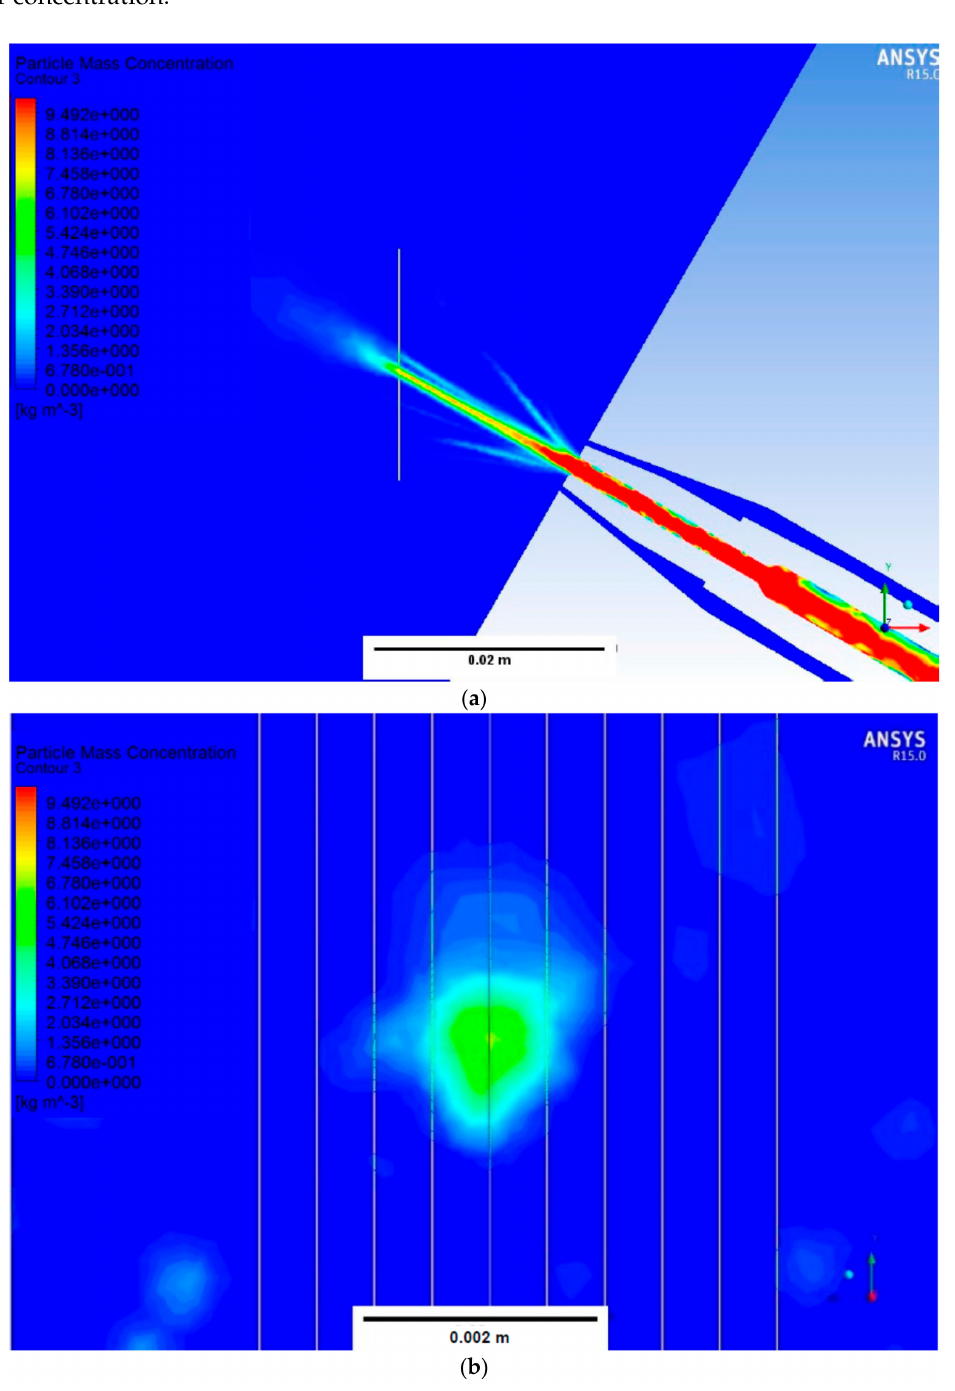
Figure 9. ( a ) Particle mass concentration along the nozzle axis; ( b ) particle mass concentration at the deposition plane and the 10 evaluation